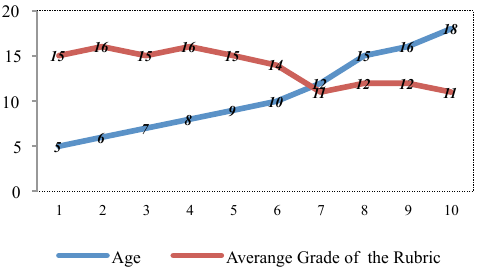
Figure 7. Age of the teachers vs. grade of the rubric .